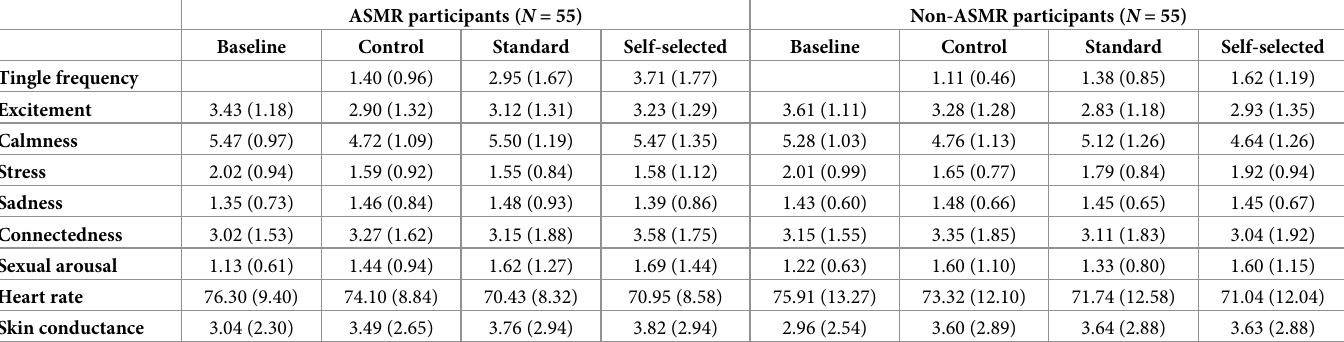
Table 3. Study 2 raw means and standard deviations for self-reported affect, heart rate, skin conductance level, and tingle frequency for each video type and partici- pant group. ASMR participants ( N = 55) Non-ASMR participants ( N = 55) Baseline Control Standard Self-selected Baseline Control Standard